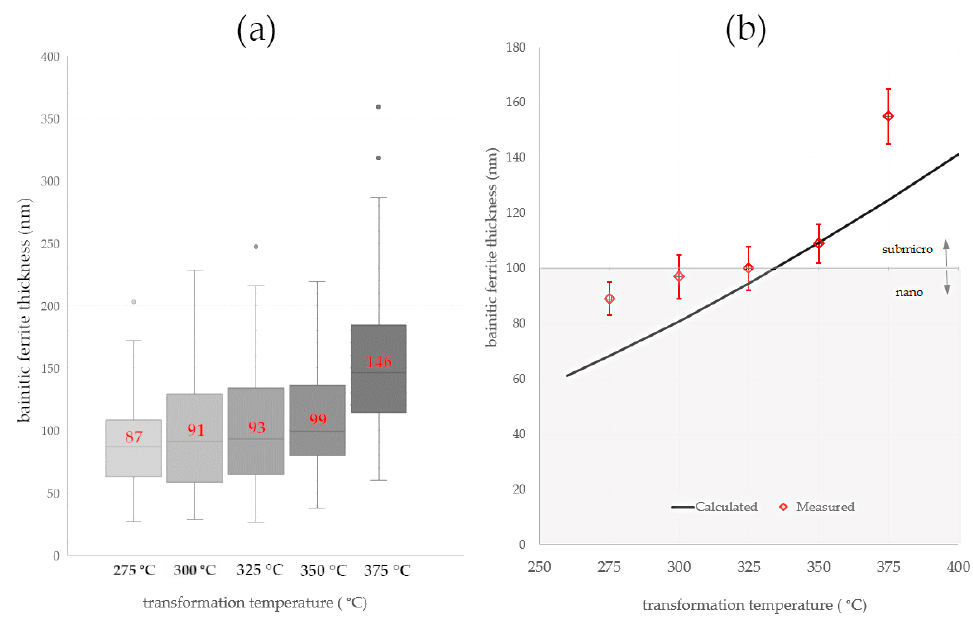
Figure 10. ( a ) Boxplots representing the median and interquartile range of bainitic ferrite thickness in relation to transformation temperature. ( b ) Comparison of calculated and measurement results expressed as average value and 95% con fi dence interval.